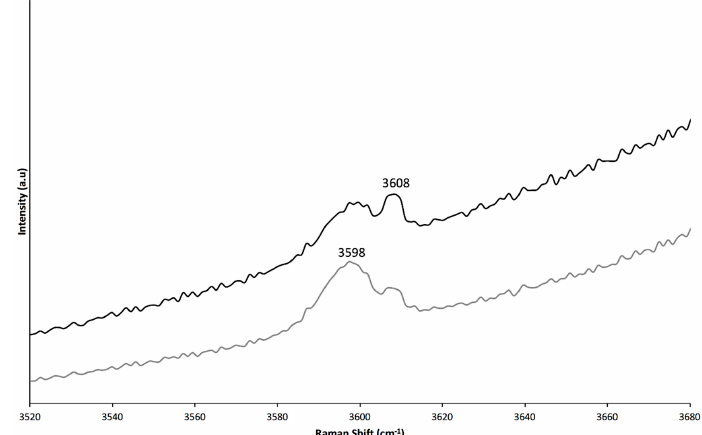
Figure 23. Raman spectra from 3520 to 3680 cm − 1 of an emerald from Ethiopia. The black and grey spectra are acquired with the laser beam perpendicular to the c ‐ axis and parallel to the c ‐ axis, respectively. Note that the upper spectrum is shifted higher for clarity.